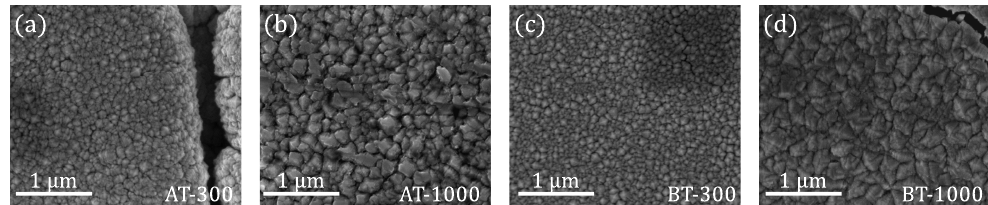
Figure 7. Scanning electron microscopy images of ( a , b ) the samples AT-300 and AT-1000 deposited from the Alloytarget and ( c , d ) samples BT-300 and BT-1000 sputtered using the